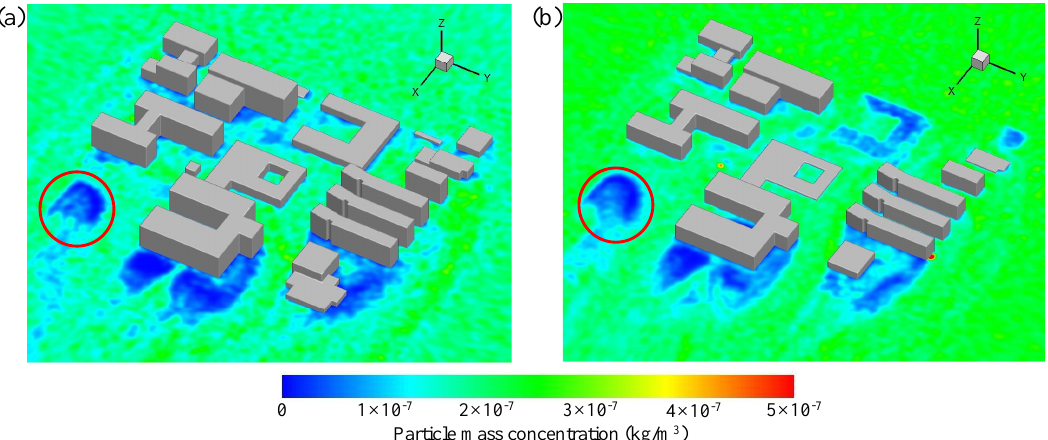
Figure 11. Contours of particle mass concentration on the different horizontal planes at t = 670 s: ( a ) z = 2 m and ( b ) z = 10